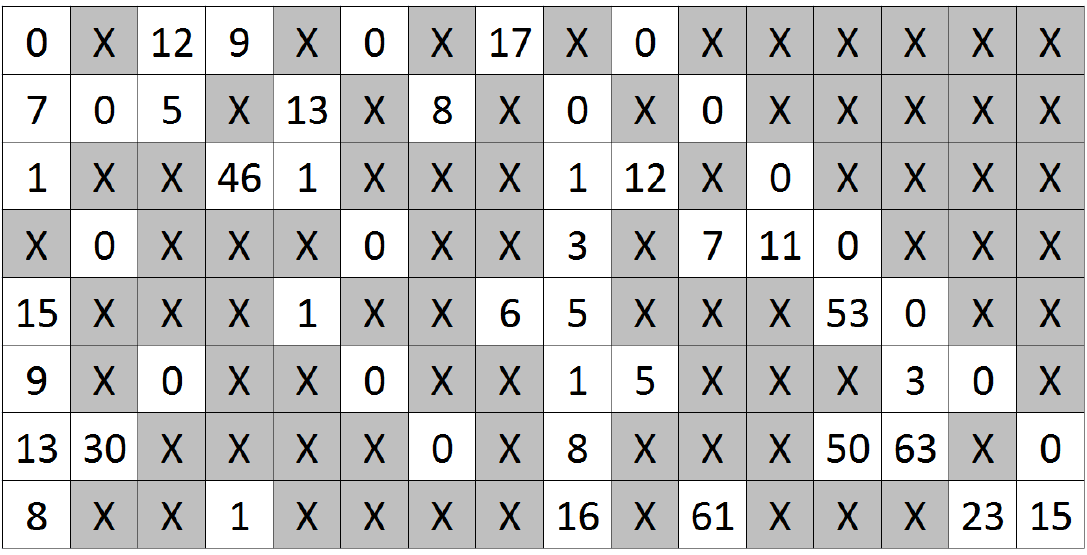
Figure 2. QC-LDPC offset matrix for P = 64 and R =